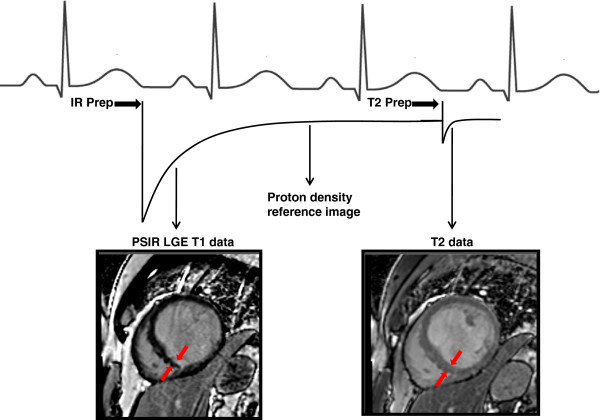
Simplified schematic of what data is acquired in MCODE: Within the same acquisition, MCODE produces both a LGE T1 image and a T2-weighted image at similar time points in the cardiac cycle. The LGE image is comparable to conventional methods with nulled, normal myocardium and bright MI. The T2-weighted image easily differentiates fluid (blood) from solid tissue (myocardium) but has minimal T1-weighting. Thus, the MI looks comparable to viable myocardium, and the endocardium is better delineated than on LGE images. Red arrows indicate the location of a MI on both the LGE T1 image (left) and the T2-weighted image (right).